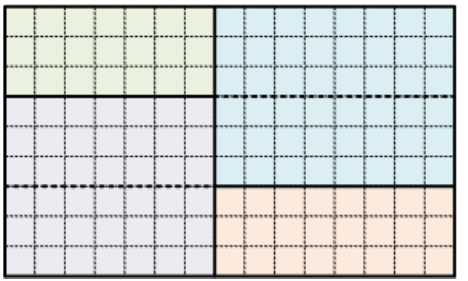
Figure 4. Example of proposed Slice-oriented partitioning (4 subpictures, 2 tiles, 6 slices).